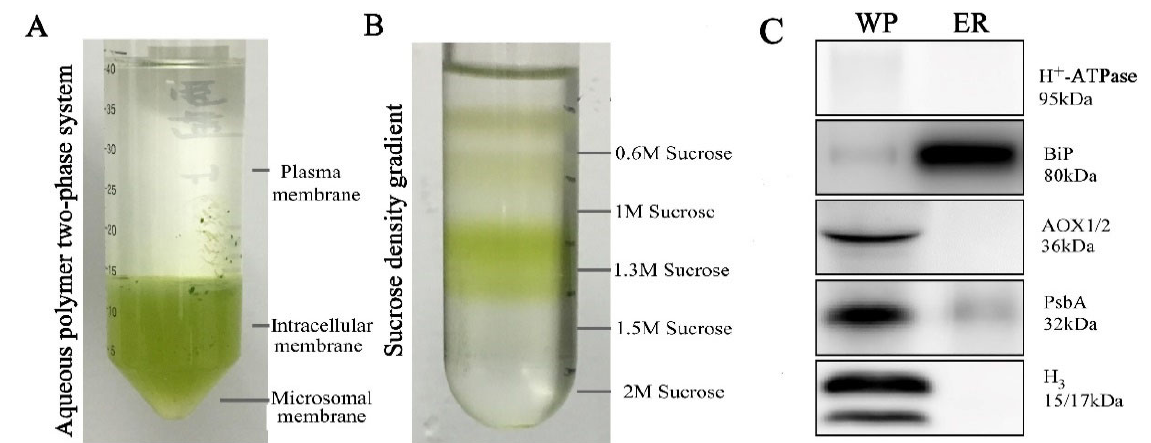
Figure 2. Purity assessment and immunoblotting analysis of the extracted ER proteins. ( A ) Discontinuous Percoll gradient. ( B ) Morphological observation of isolated chloroplasts. ( C ) Immunoblotting analysis using antibodies against plant cell compartment markers, including H+-ATPase (Plasma membrane), BiP (Endoplasmic reticulum), AOX1/2 (Mitochondrion), PsbA (Chloroplast) and anti-H3 (Nuclear). WP: whole protein of wheat leaves.